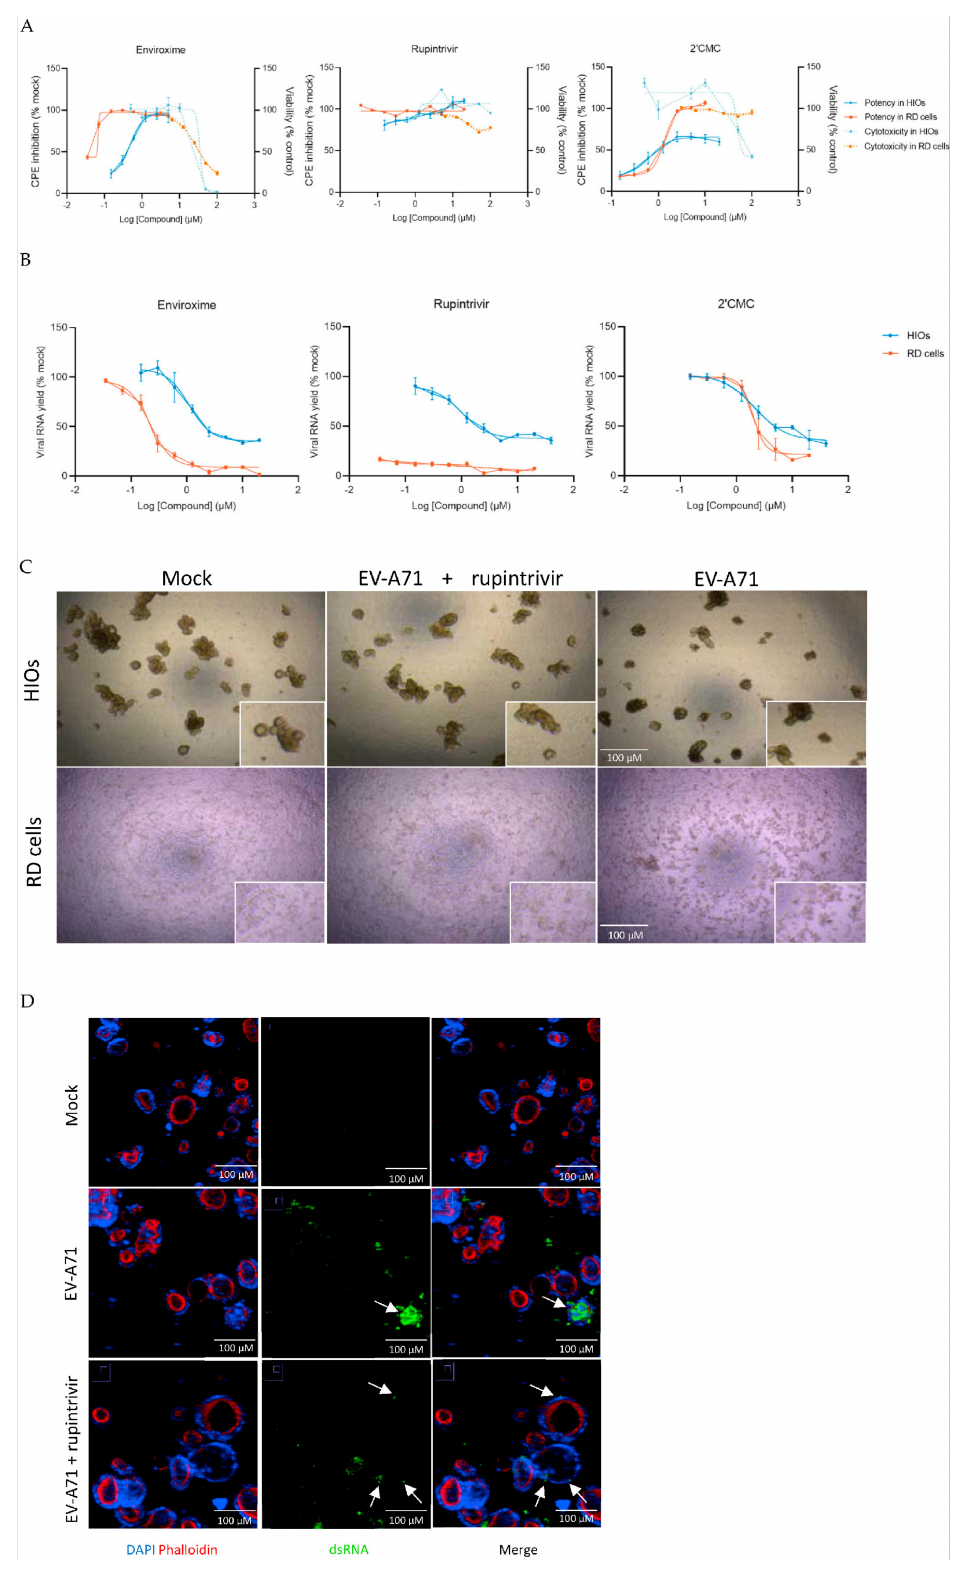
Figure 4. Comparison of antiviral activity determined by CPE inhibition and viral RNA yield between HIOs and RD cells. ( A ) Viability of HIOs and RD cells was measured, using Cell Titer-Glo 3D or Cell Titer-Glo, after 72 h of EV-A71 infection at MOI 0.1 and incubation with compounds at indicated concentrations. CPE inhibition is calculated based on percentage of mock-infected control. The